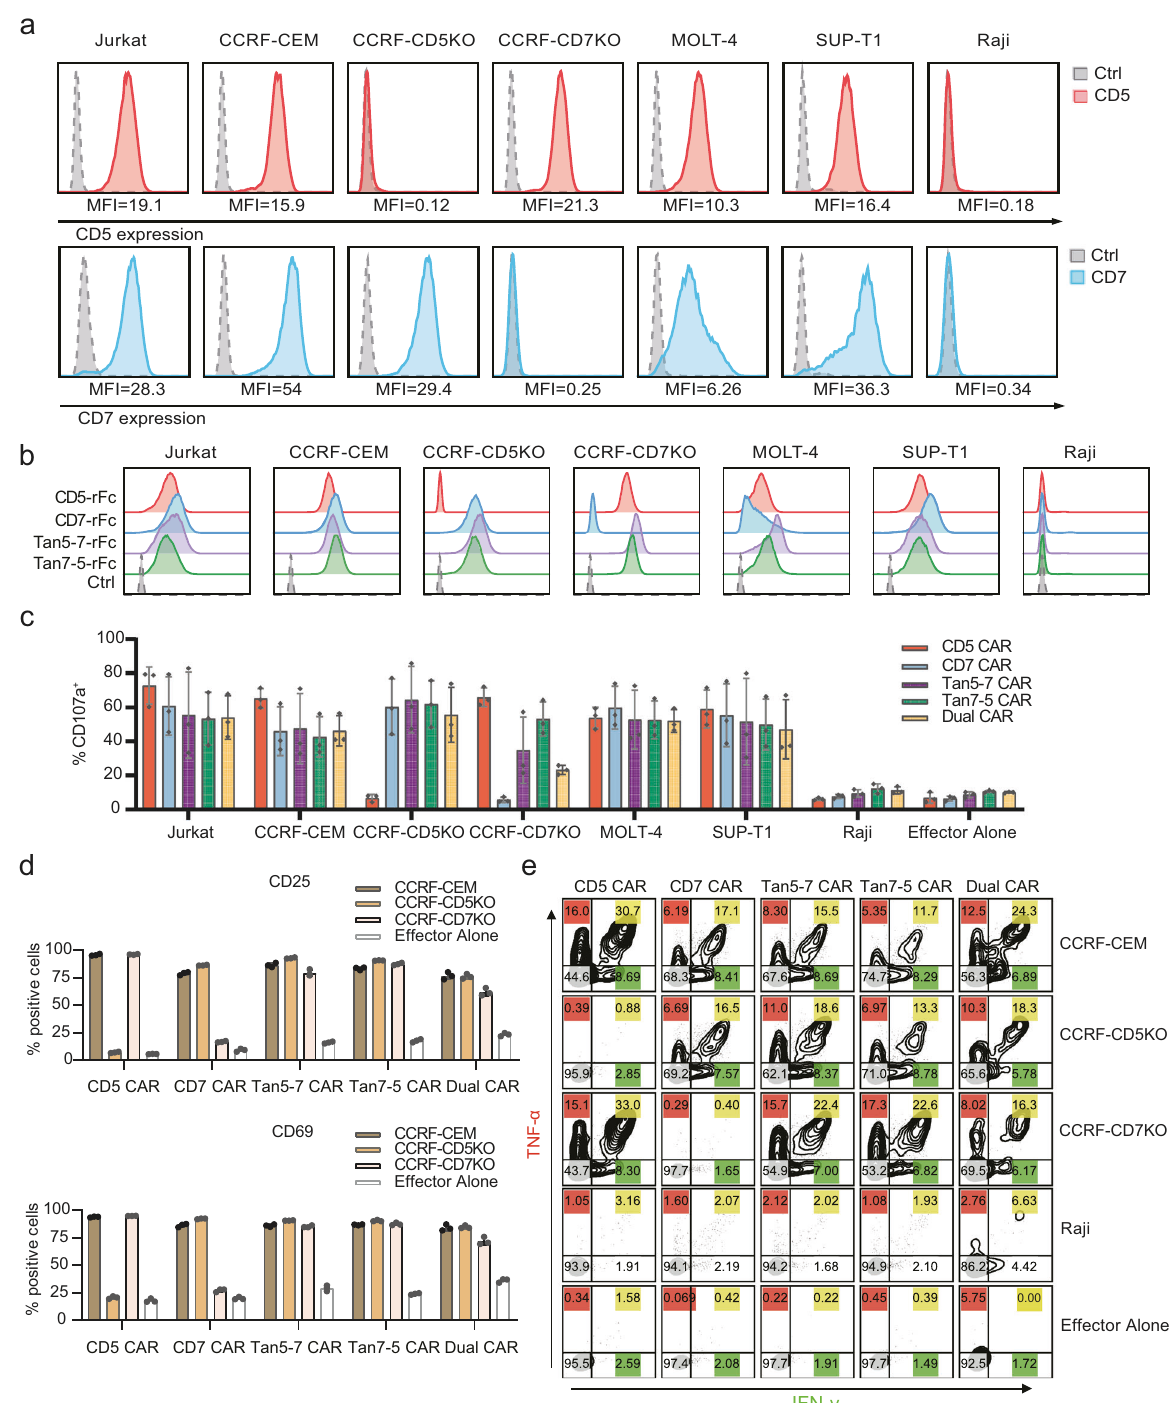
Fig. 3 CD5/CD7 bispeci fi c CAR-T cells can be activated by CD5 + and/or CD7 + cells. a Surface expression of CD5 (red solid histograms) and CD7 (blue solid histograms) in T-ALL and T-lymphoma cell lines in comparison with isotype control (dotted line gray histograms) measured using fl ow cytometry. b Cell lines were stained with CD5-rFc, CD7-rFc, Tan5-7-rFc, Tan7-5-rFc antibodies, and isotype control, followed by PE- conjugated anti-rabbit IgG antibody, then analyzed using fl ow cytometry. c The degranulation assay of fi ve CARs. The results are displayed as mean ± SD for three donors. d Expression of the T-cell activation markers CD69 and CD25 on CAR-T cells following a 24 h co-incubation with CCRF-CEM, CCRF-CD5KO, or CCRF-CD7KO. Gated on CD8 + EGFRt + cells. The data represents mean ± SD ( n = 3). e Representative fl ow cytometry plots showing intracellular cytokine staining for pro-in fl ammatory cytokines (TNF- α and IFN- γ ) after CAR-T cells cocultured with indicated target cells at an E:T ratio of 1:5 for 24 h